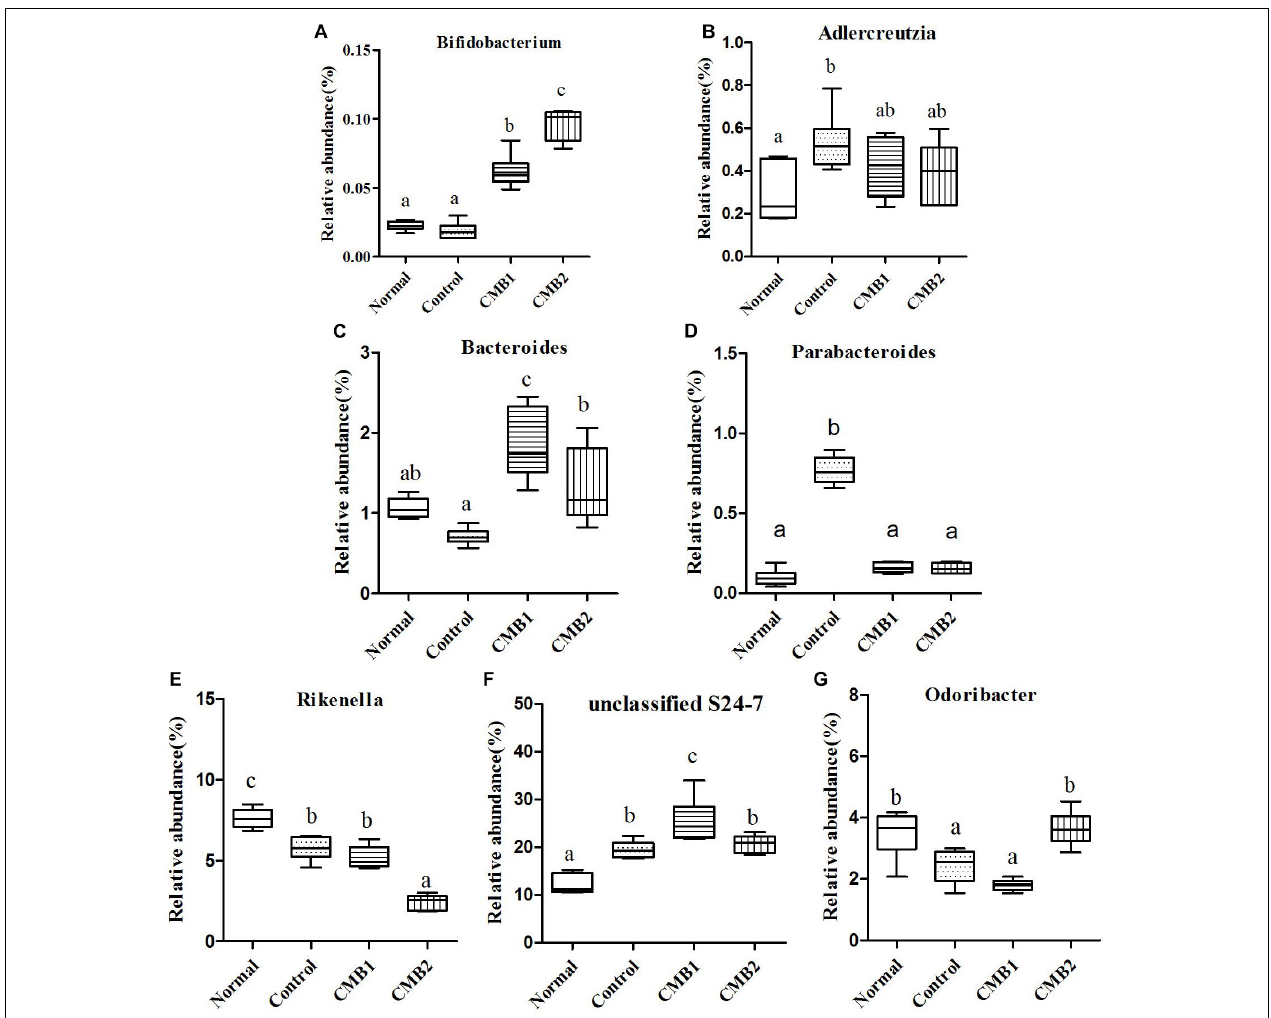
FIGURE 6 | Relative abundance (%) of caecal microbial taxa at the genus level in constipated mice fed CMB. (A) Bifidobacterium , (B) Adlercreutzia , (C) Bacteroides , (D) Parabacteroides , (E) Rikenalla , (F) Unclassified S24-7, and (G) Odoribacter